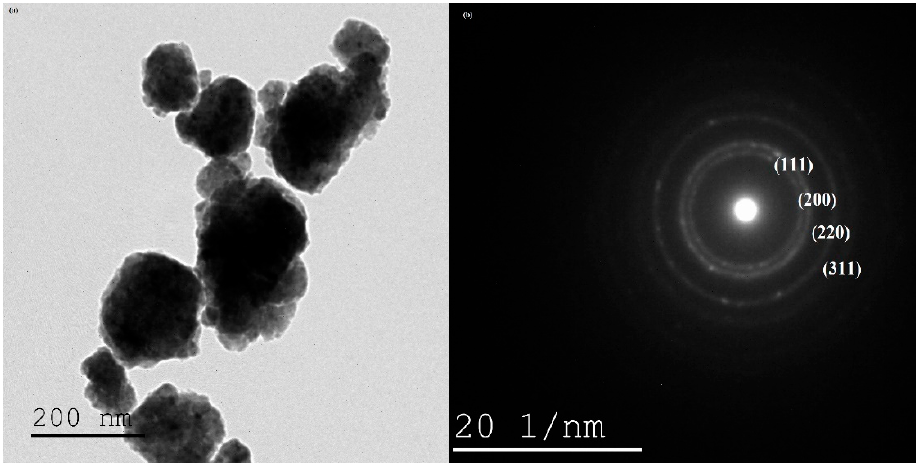
Figure 4. ( a ) HRTEM image and ( b ) SAED patterns of the powder after MA for 20 h.